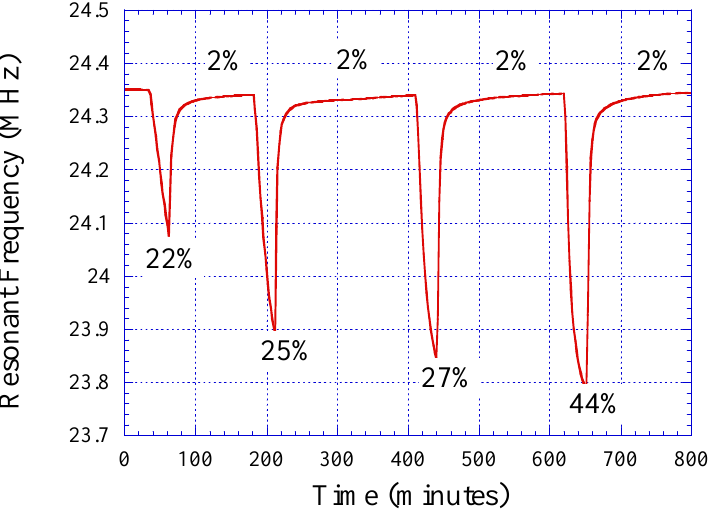
Figure 10. The response of the sensor when it was cycled between dry air (2 % RH) and increasing humidity levels from 22 % RH to 44 % RH. The room temperature was 24 (cid:176)